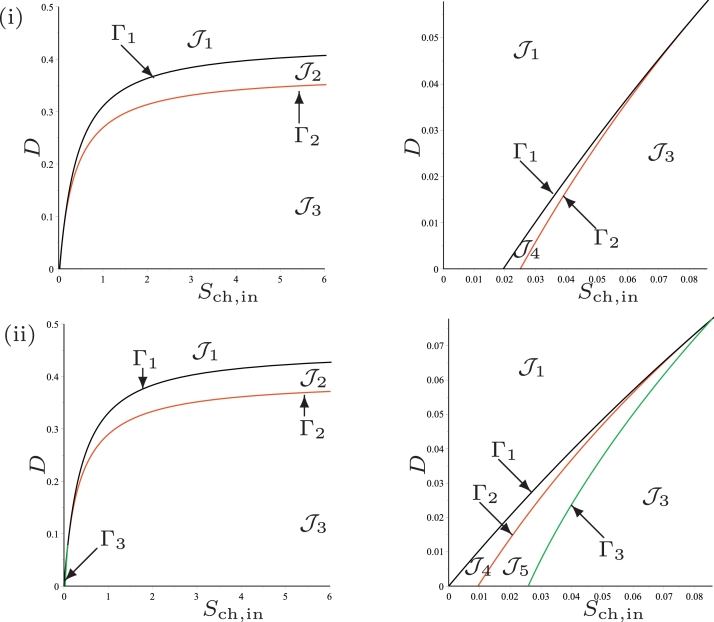
The curves Γ1 (black), Γ2 (red) and Γ3 (green) for case (a). (i) : regions of steady-state existence, with maintenance. On the right, a magnification for 0<D<D3=0.058 showing the region J4. (ii) : regions of steady-state existence and their stability, without maintenance. On the right, a magnification for 0<D<D3=0.078 showing the regions J4 and J5. (For interpretation of the references to colour in this figure legend, the reader is referred to the web version of this article.)